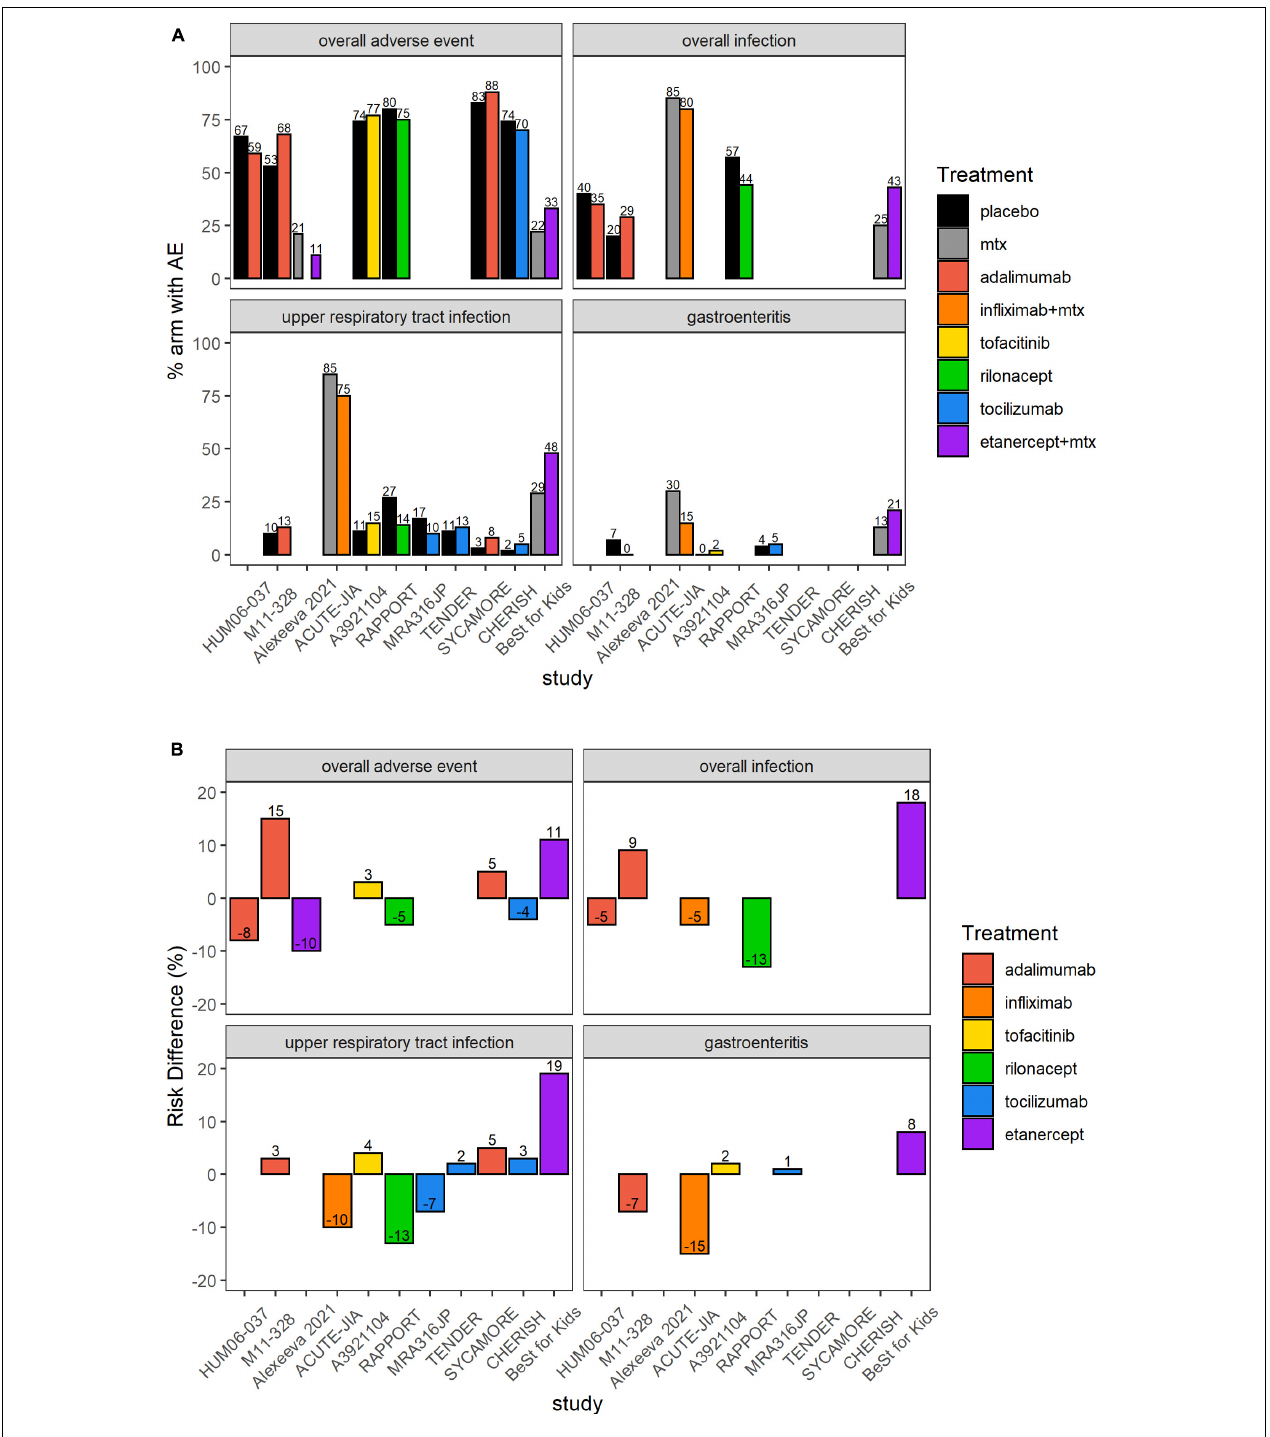
FIGURE 4 | Overall AEs, overall infections, upper respiratory infections or gastroenteritis in the 12 included RCTs. (A) Proportion (%) of patients with AEs in each study arm. Higher proportion of AEs in the placebo or SOC arm favors experimental treatment. (B) RD (%) of patients with AEs in each treatment arm compared to placebo or SOC. Treatment effect < 0 favors experimental treatment over placebo or SOC. AE, adverse event; MTX, methotrexate; SOC, standard of care. In the ACUTE-JIA study, the rate of overall AEs was 4.8 events/patient-year in the infliximab plus methotrexate arm and 6.5 events/patient-year in the methotrexate monotherapy arm. In the TENDER study, the rate of overall AEs was 9.3 events/patient-year in the tocilizumab arm and 9.4 events/patient-year in the placebo arm; corresponding rates of overall infections were 3.4 vs. 2.9 events/patient-year.